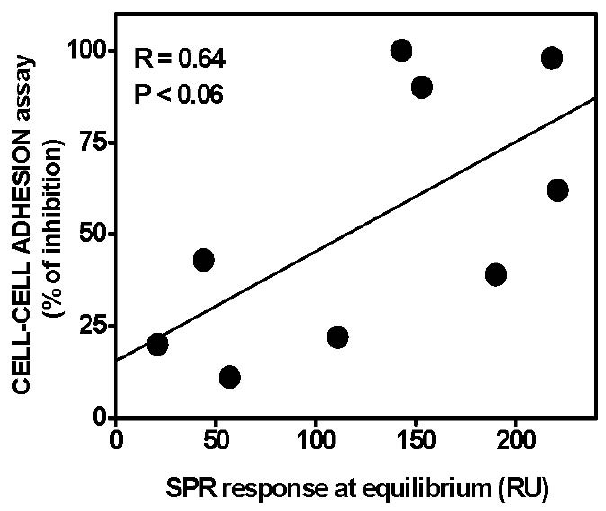
Figure 7. Correlation between SPR-generated binding parameters for the interaction of FGF2 with K5 derivatives and their antiangiogenic potential. SPR response at equilibrium of K5 derivatives to immobilized FGF2 were plotted versus the capacity of the FGF2 antagonist to inhibit HSPG/FGF2/FGFR1 ternary complex formation in the FGF2- dependent CCA assay (expressed as % of inhibition when the compounds were tested at the dose of 10  g/mL). The data from CCA assays are the mean value from three different experiments performed in duplicate. The SPR responses at equilibrium are taken from a single experiment out of three giving consistent